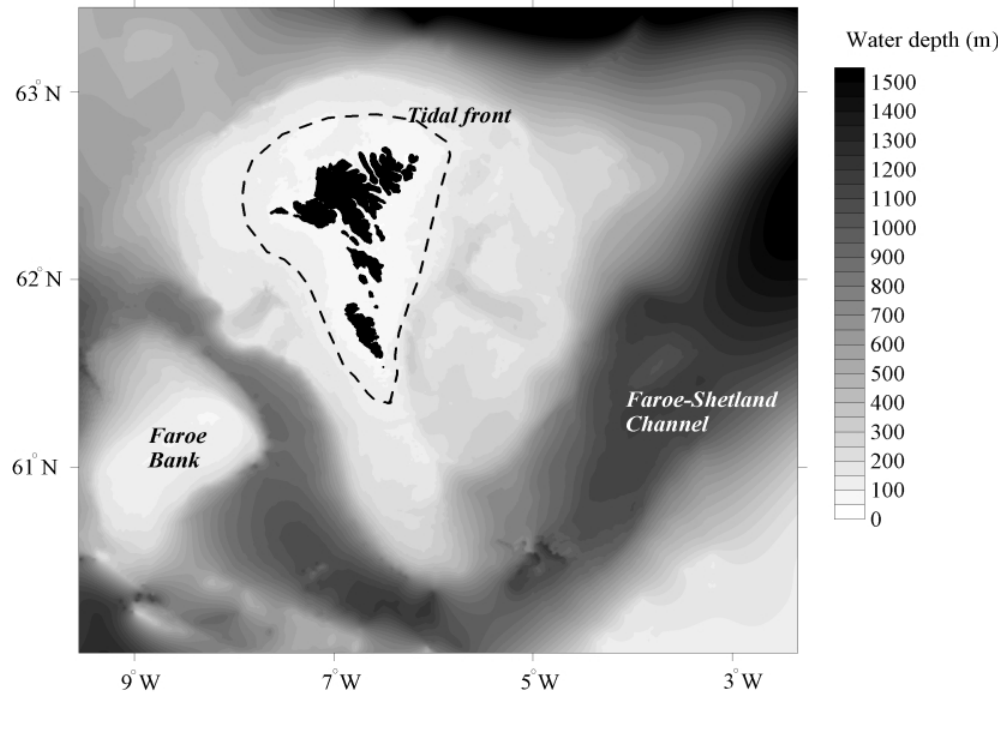
Fig. 1 . The distribution of water depth on the Faroese shelf with names of locations mentioned frequently in the text. The map has been contoured from a 300 m resolution grid based on detailed near-shore bottom depth soundings, 3D-seismic activity and depths from echo soundings along the ship tracks of RV Magnus Heinarsson and RCGV Tjaldrid (from Simonsen et al.